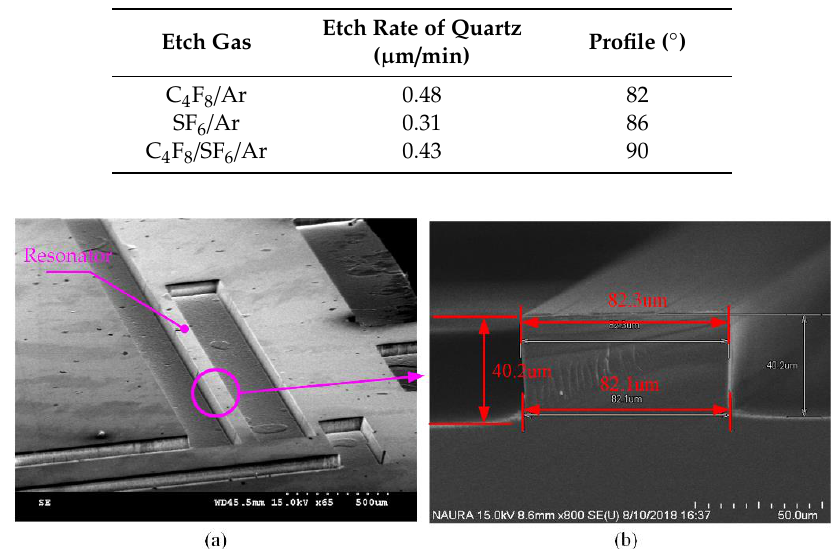
Figure 14. ( a ) SEM image of etched quartz resonator; ( b ) the cross-section view of resonator.